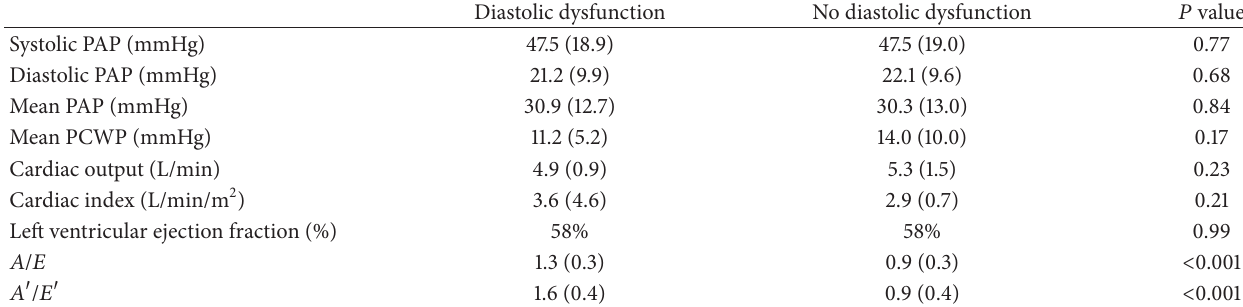
Table 3: Catheterization and hemodynamic profile of diastolic dysfunction and nondiastolic dysfunction groups.